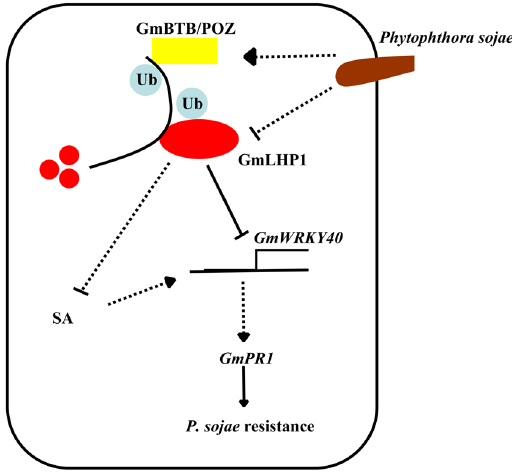
Fig. 8 Model of the role of GmBTB/POZ , GmLHP1 , and GmWRKY40 expression in the response of soybean to Phytophthora sojae infection.